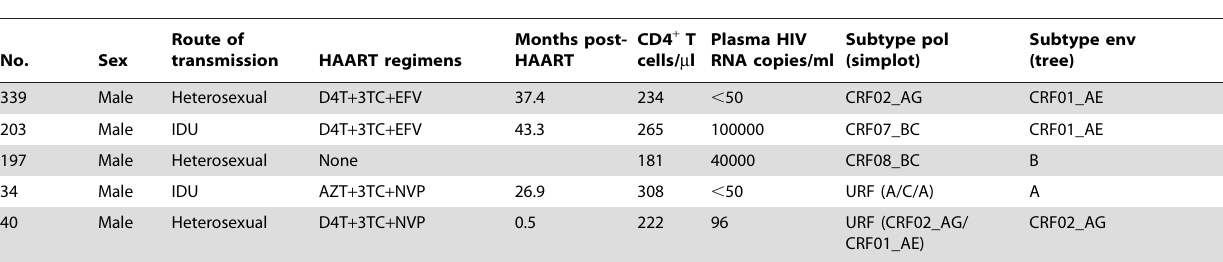
Table 2. Characterizations of patients having pol and env sequences with potential